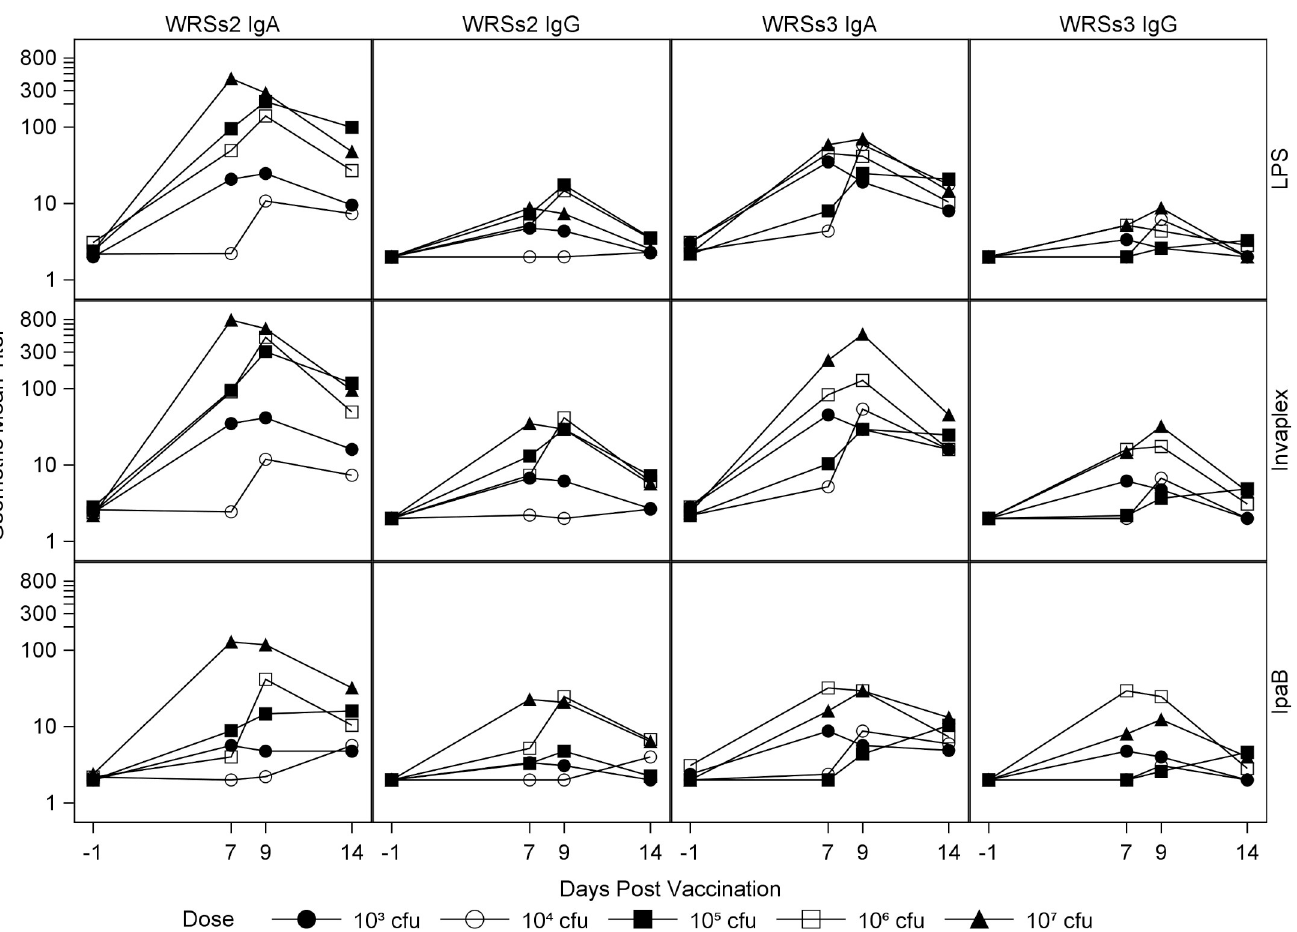
Fig 2. Kinetics of ALS responses following vaccination with WRSs2 and WRSs3. The Y axis data represents the geometric mean titer (GMT) of the raw ALS titer values at Day -1, Day 7, Day 9, and Day 14. For each S . sonnei antigen, LPS, IVP and IpaB in each cohort (cohorts marks: closed circle-10 3 CFU, open circle-10 4 CFU, closed square- 10 5 CFU, open square- 10 6 CFU and closed triangle- 10 7 CFU). The X axis shows the day post-vaccination when ALS was measured.